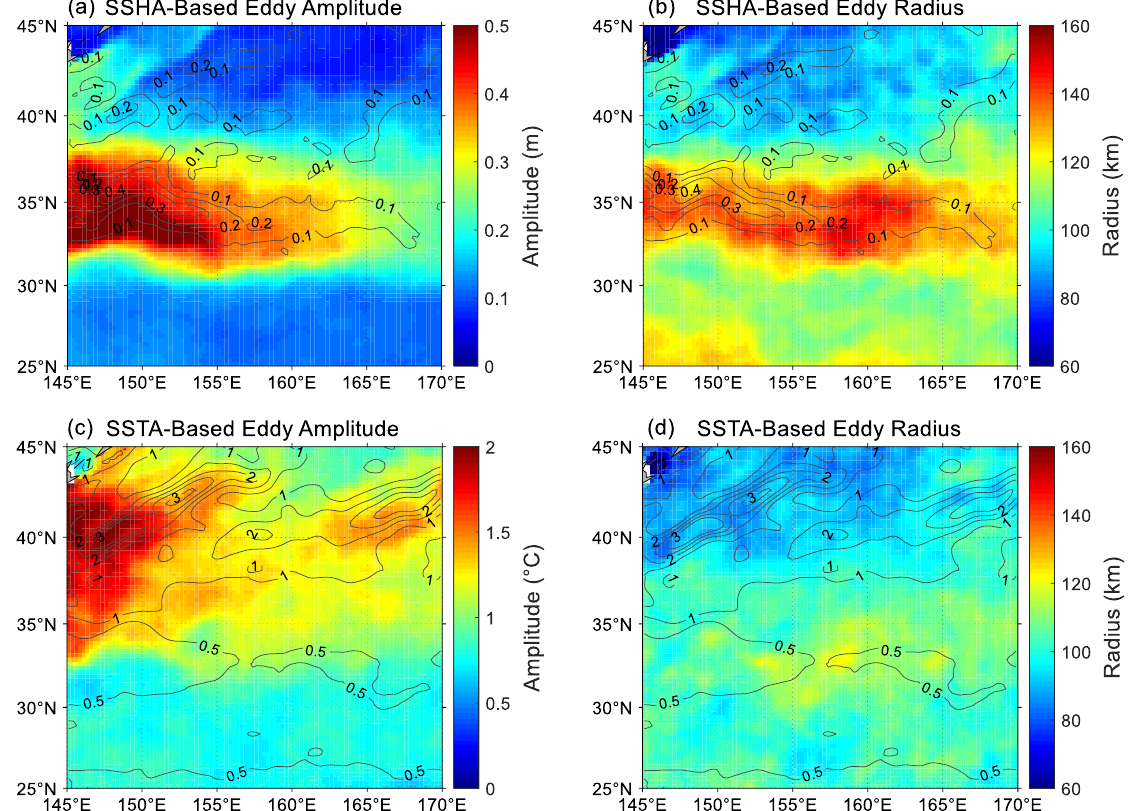
Figure 11. The maps of the mean amplitude and radius scales from SSHA-based ( a , b ) and SSTA- based ( c , d ) eddy trajectories with lifetime ≥ 30 days. Contours in panel a and b are the gradient of climatological mean absolute dynamic topography ADT (unit: m/100 km); contours in panel c and b are the gradient of climatological mean SST (unit: °C/100 km).